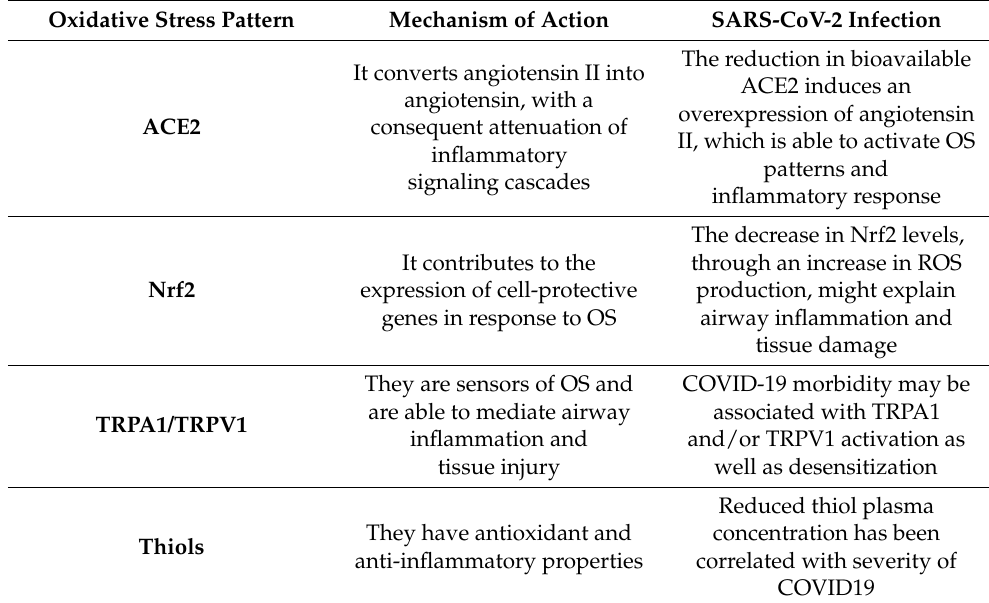
Table 1. Oxidative stress patterns involved in SARS-CoV-2